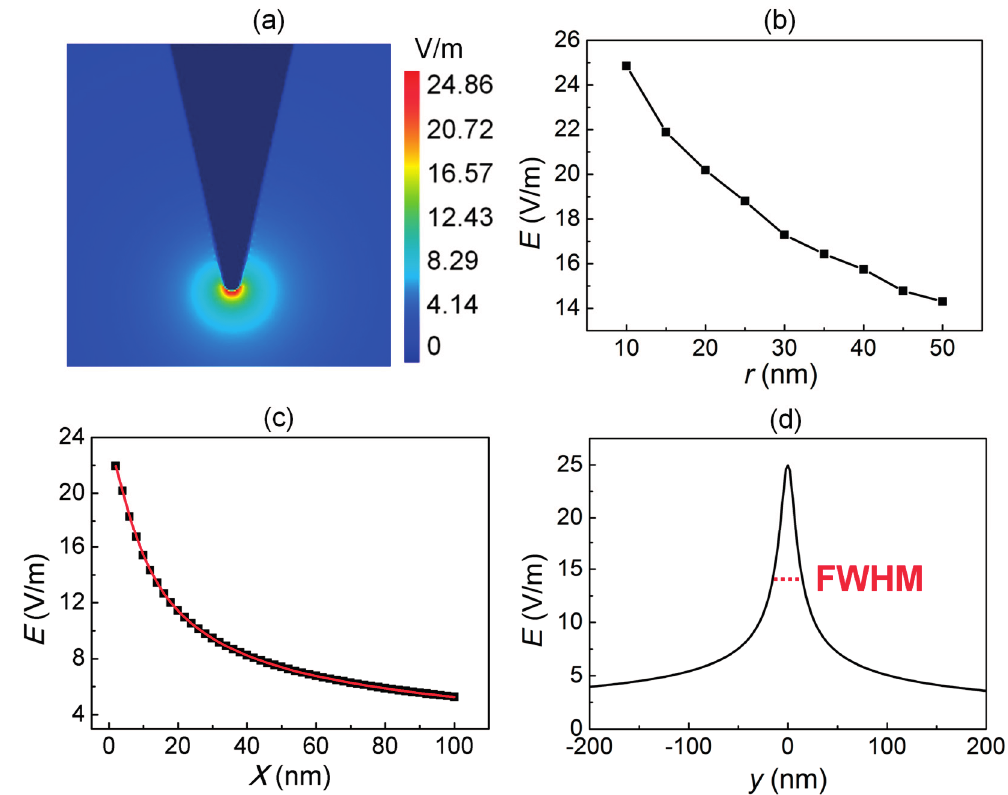
Figure 2. ( a ) Electric field distribution on the Au nanotip with a radius of 10 nm; ( b ) The maximum electric field amplitude E as a function of the radius r of the tip; ( c ) The electric field distribution along the x -axis and the red line is a reciprocal square law fitting; ( d ) The electric field distribution along the y -axis and the full width at half maximum (FWHM) is marked with a dash